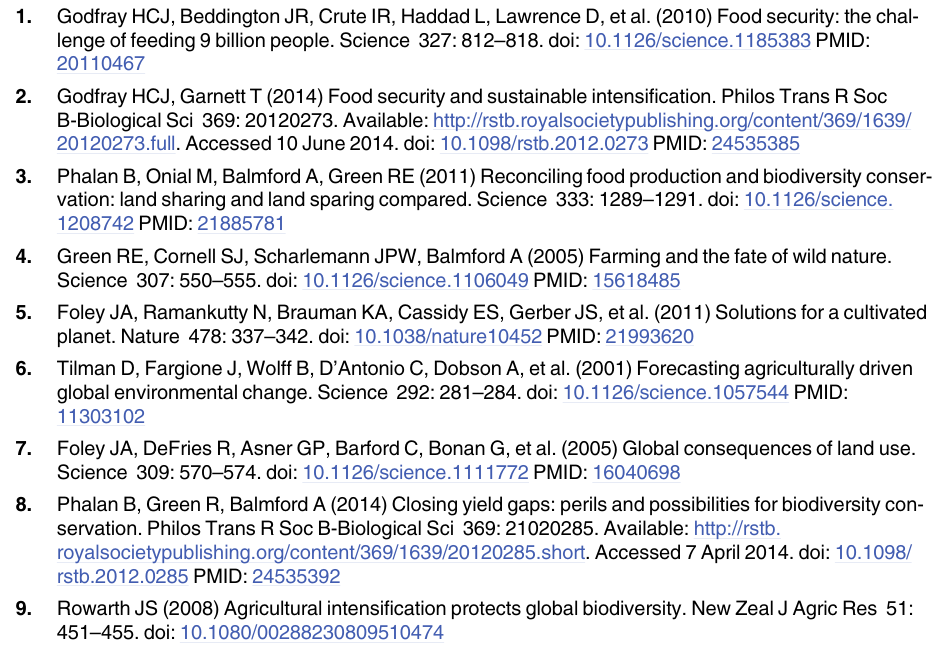
S7 Fig. Predicted relationships between surrounding agricultural land-use intensity and soil moisture factor within fenced and unfenced forest remnants. The mean (± 1 S.E.) fitted relationships were derived from the final model-averaged solution (Table 2) using the ‘ lmePre- dict ’ function, while holding other fixed effects constant at their mean values. Symbols repre- sent the raw means (± 1 S.E.). The grey shaded interval represents the raw mean (± 1 S.E.) of the soil moisture factor at the reference forest interior sites (243 – 420 m from edge). Note that the predicted relationships are conditional on the random effects specified in the model. S8 Fig. Predicted relationships between surrounding agricultural land-use intensity and soil biogeochemistry within fenced and unfenced forest remnants, replotted as gravimetric response measures rather than as volumetric response measures. See Fig. 4 for